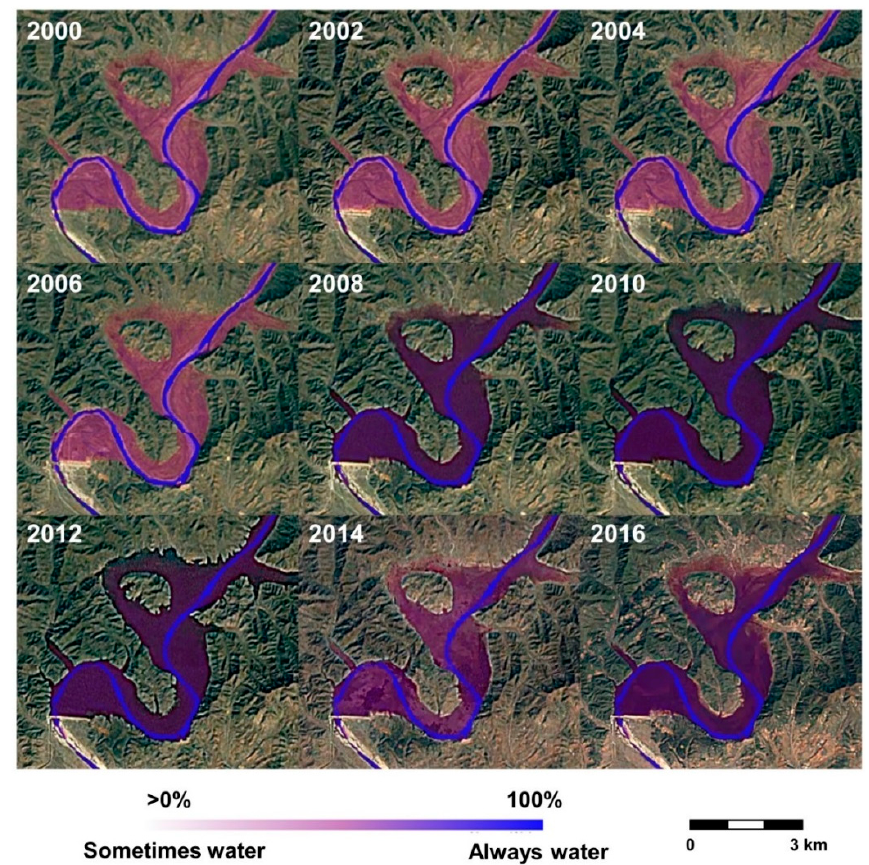
Figure 8. Biennial water occurrence maps (2000–2016) over the Imjin River near the Hwanggang Dam.